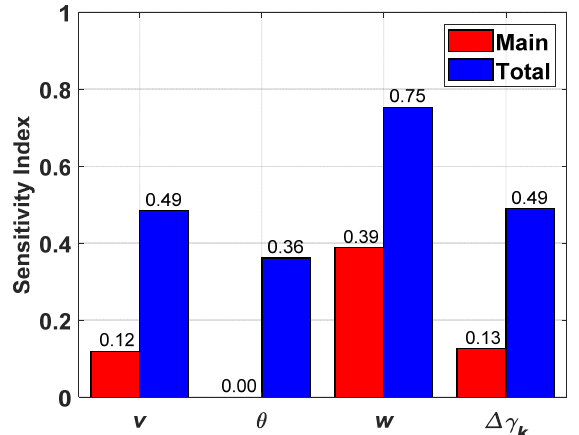
Table 2. Ranges of factors used in sensitivity analysis. Factor